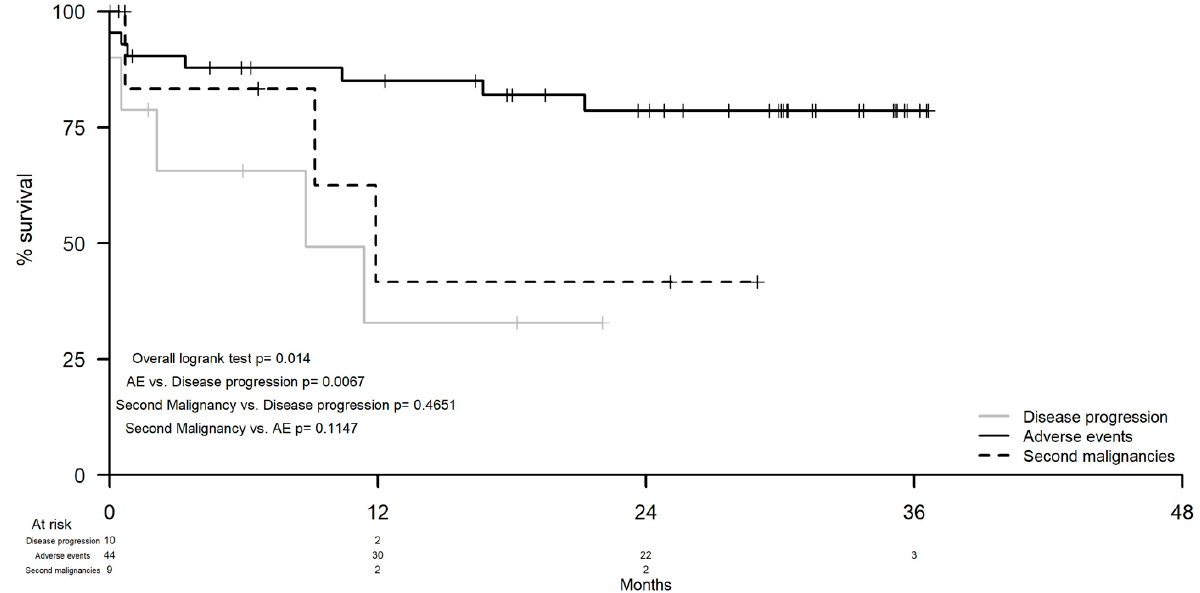
Figure 4. Survival probability from treatment discontinuation according to the reason for discontinuations, disease progression, adverse event, and second malignancy. ations, disease progression, adverse event, and second